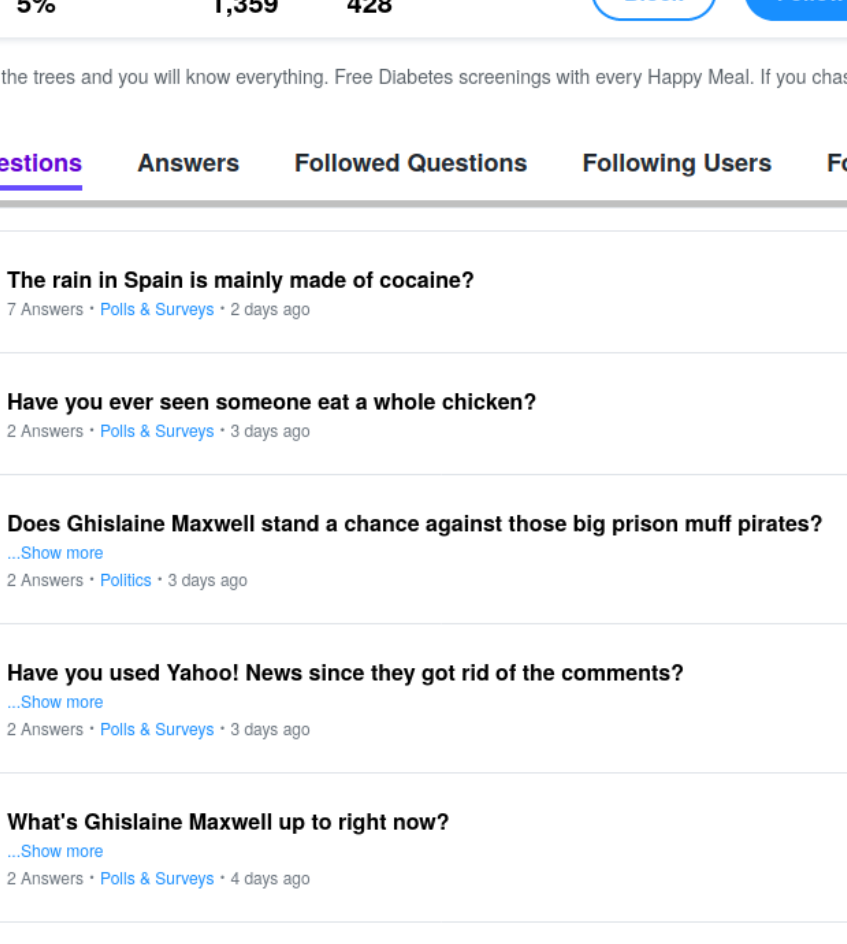
Figure 1. Public profile belonging to ElmsofTaste. This page shows a self-description, a list of questions asked and a profile